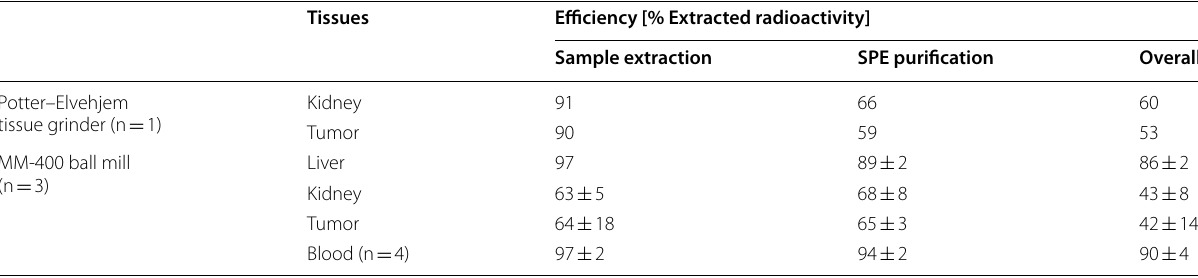
Samples were extracted using either a Potter–Elvehjem tissue grinder (n SPE purification was quantified, decay-corrected, and the overall extracted activity was calculated (values are expressed as mean